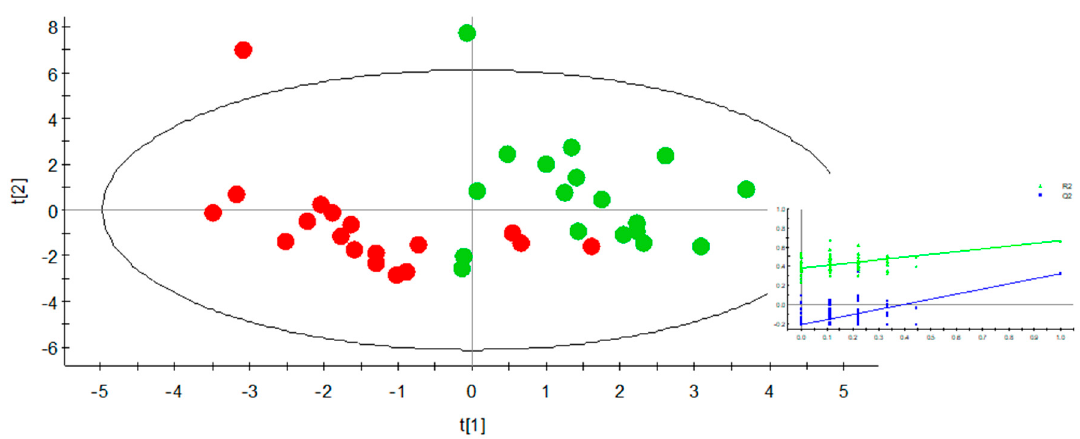
Figure 3. PLS-DA scores plot of urine samples at 12 months of age between the groups that had exercised (A and B, green) and the groups that had not exercised during the 1st half (C and D, red) with permutations plot as insert. Table 3. Summary of model characteristics from PCA and PLS-DA multivariate analyses.